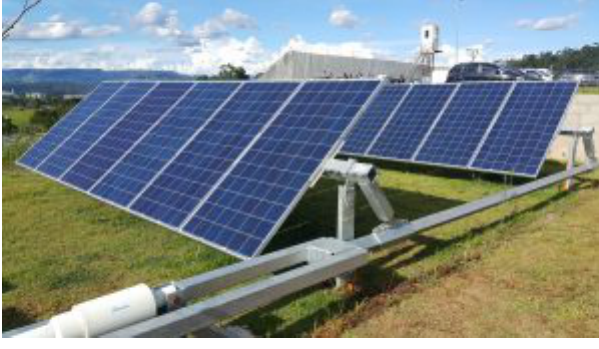
Figure 4. Horizontal single-axis tracker. Table 1. Specifications of the equipment used in